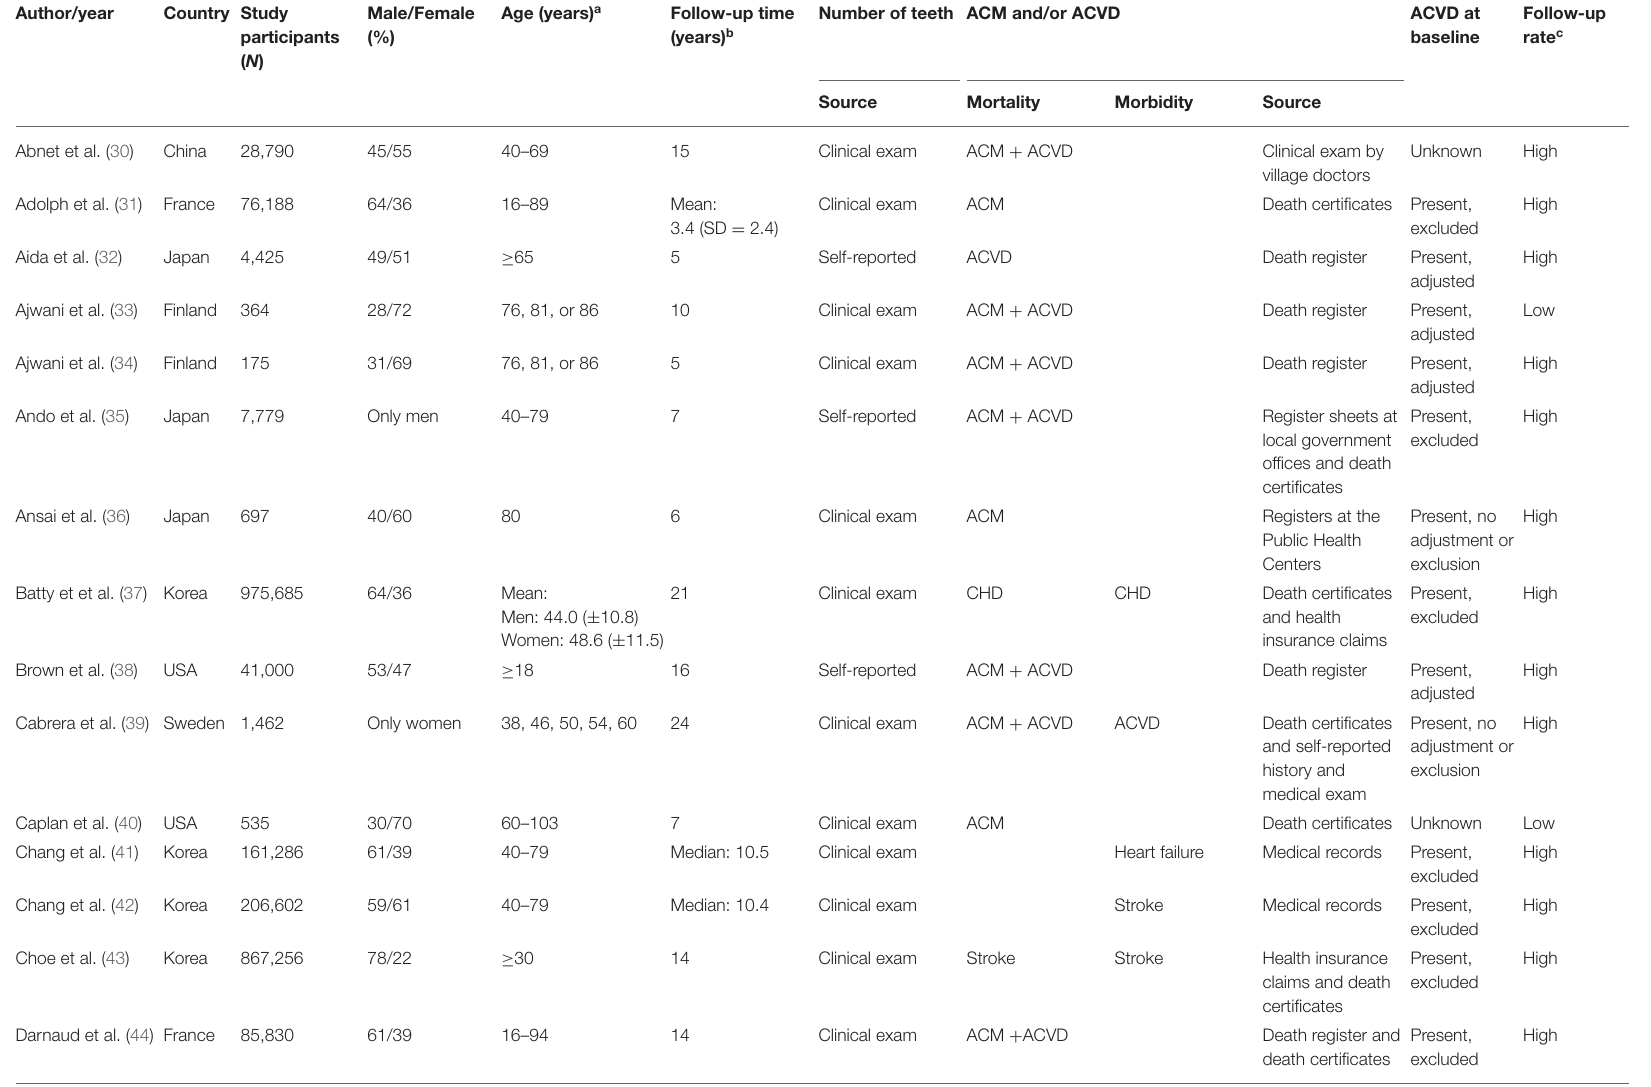
TABLE 1 | Main characteristics of the included studies ( N =